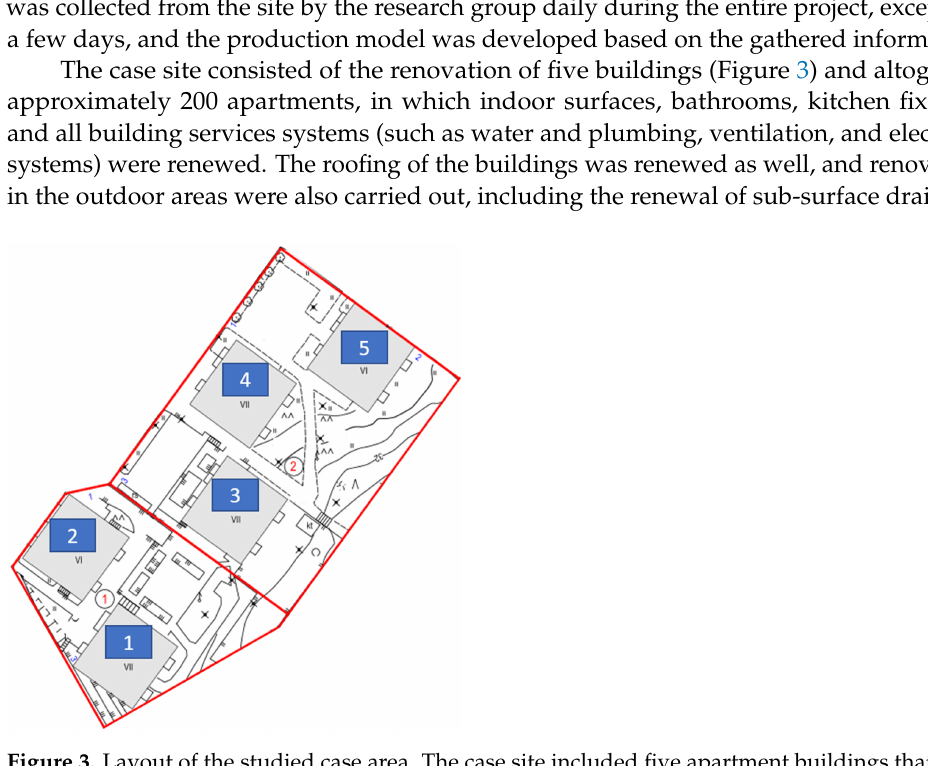
Figure 3. Layout of the studied case area. The case site included five apartment buildings that were refurbished in the order indicated by the blue